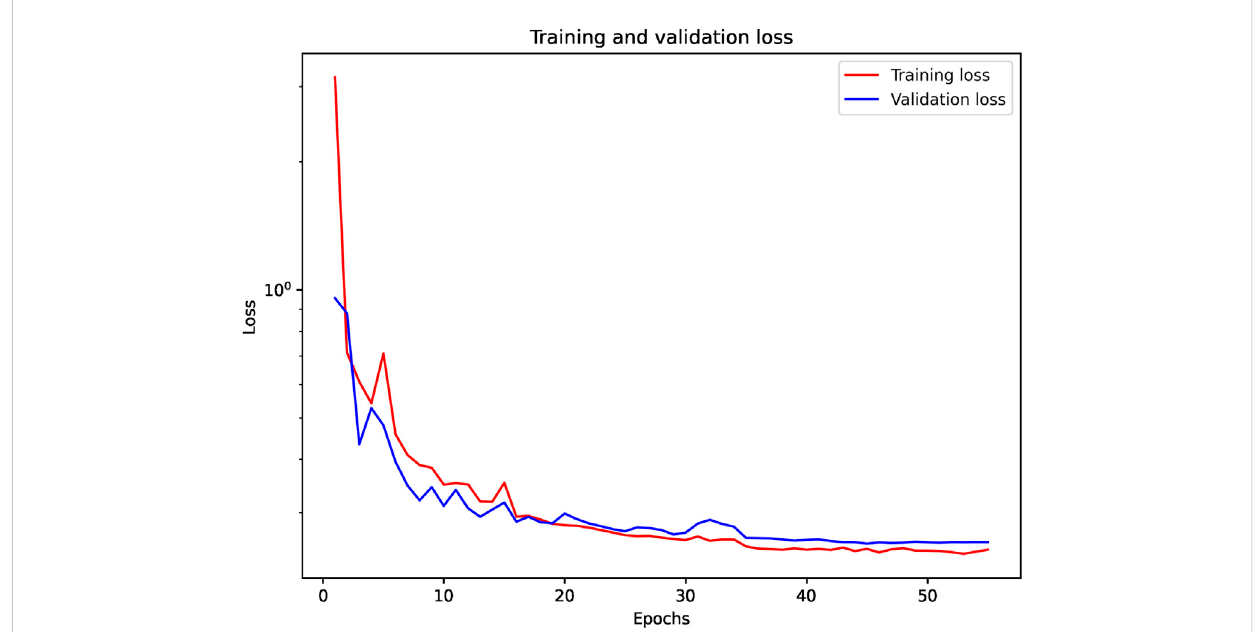
FIGURE 4 The relationship between the loss and epoch. The red line represents the training loss, and the blue line represents the validation loss.